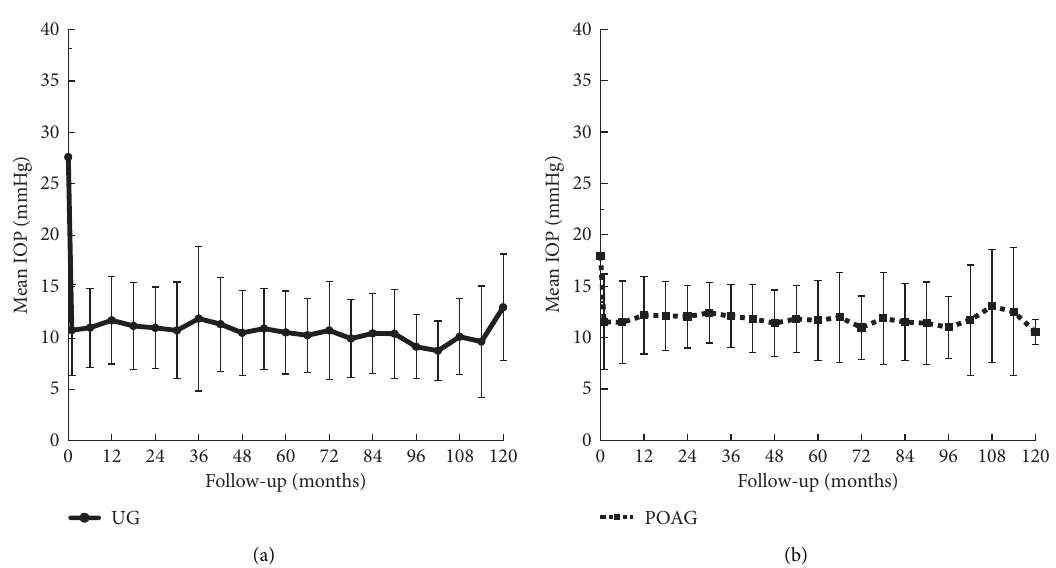
Figure 1: Mean preoperative and postoperative IOP after MMC-TLE in the UG and POAG groups. (a). UG. (b). POAG. The decrease in the median IOP was significant at all time points compared with the baseline values in both groups ( P < 0 . 05, by Student’s t -test). The error bar whiskers represent the standard deviation. Table 3: IOP and antiglaucoma medication after MMC-TLE in UG and POAG UG POAG Follow − up (mo) IOP (mmHg) Medications